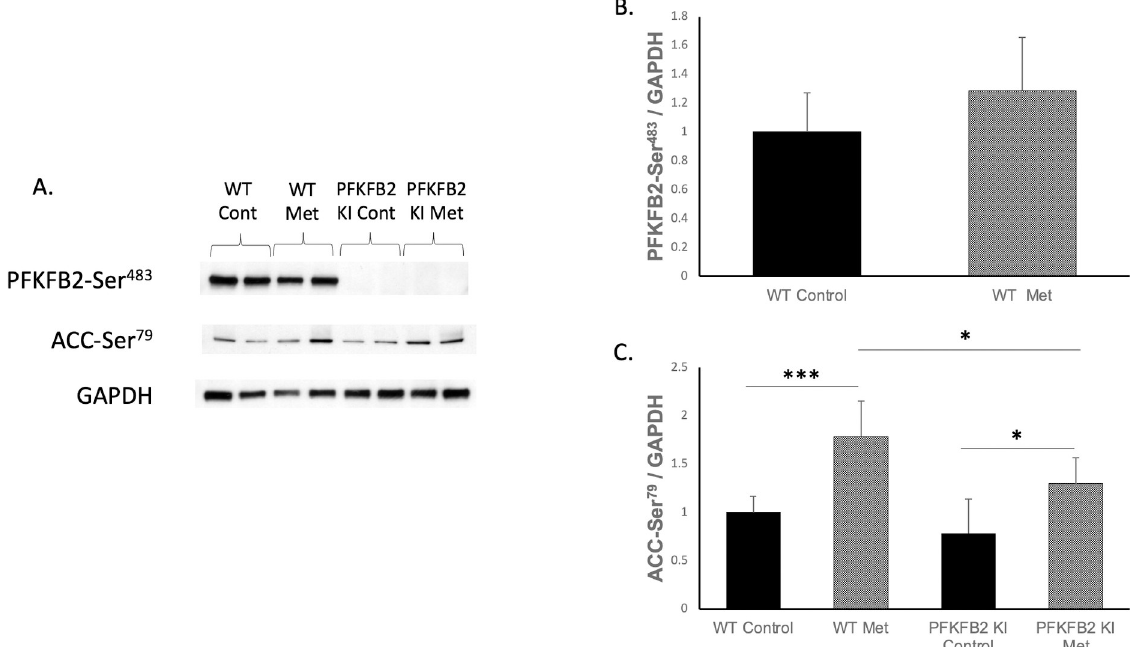
Fig 1. Expression of phosphorylation sites in cultured tubular epithelial cells from WT and PFKFB2 KI mice ± metformin stimulation (A-C). The mutated phosphorylation site at PFK-FB2-Ser 483 was not detectable in the PFKFB2 KI mice as expected ( A ). Expression of phospho- Ser 483 was not significantly different with metformin stimulation ( B ). There was increased expression of phosphorylated ACC-Ser 79 phosphorylation with metformin stimulation in both WT and PFKFB2 KI cells ( A, C ��� p < 0.001 and � p = 0.01 respectively). Expression of phosphorylated ACC-Ser 79 was decreased in PFKFB2 KI metformin cells compared to WT cells ( A, C � p = 0.02). Mean + SD.